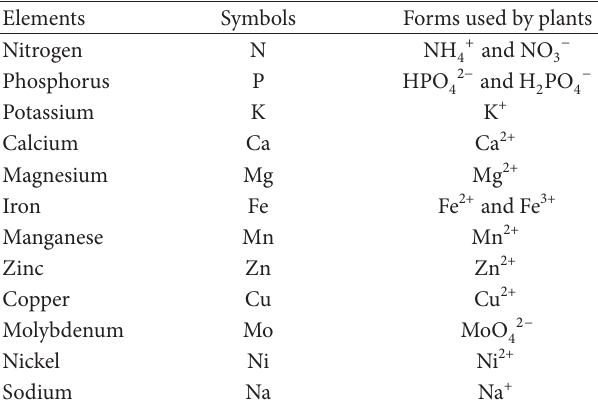
Table 1: Primary forms of some nutrients intake by plants.